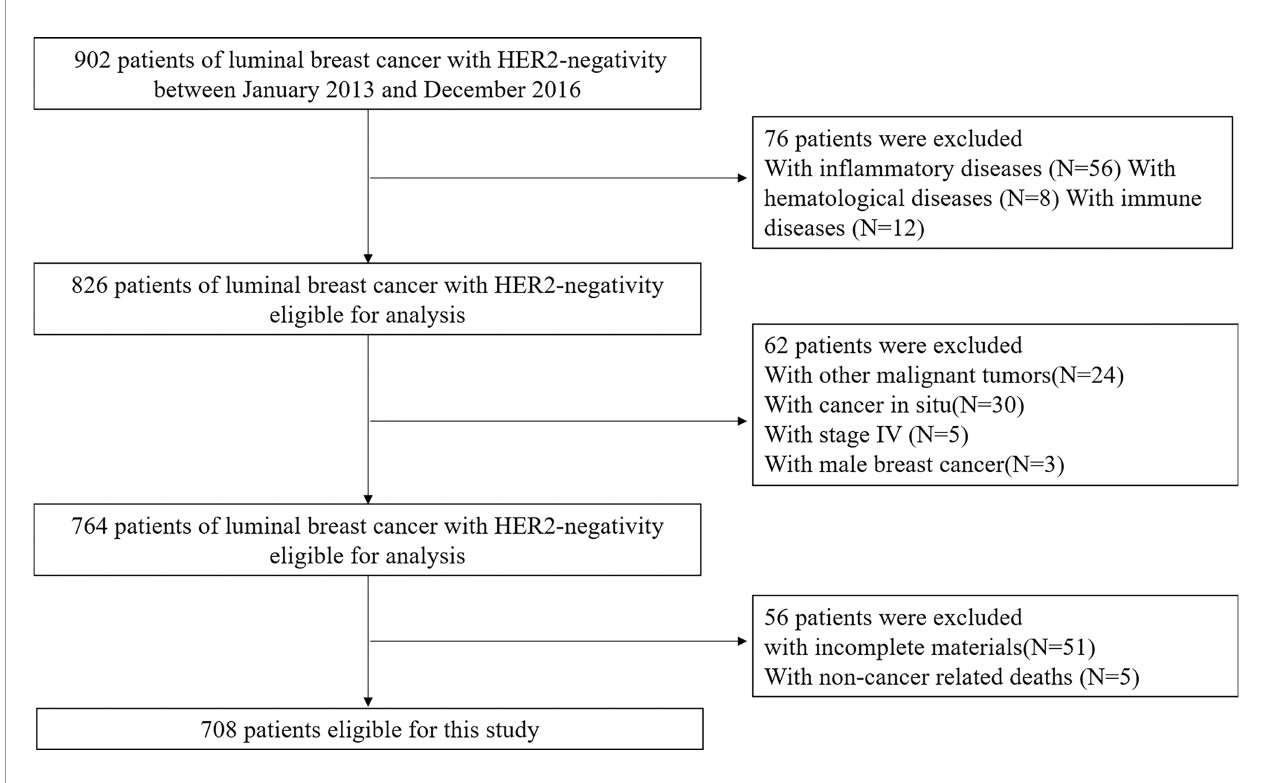
FIGURE 1 | Study fl ow